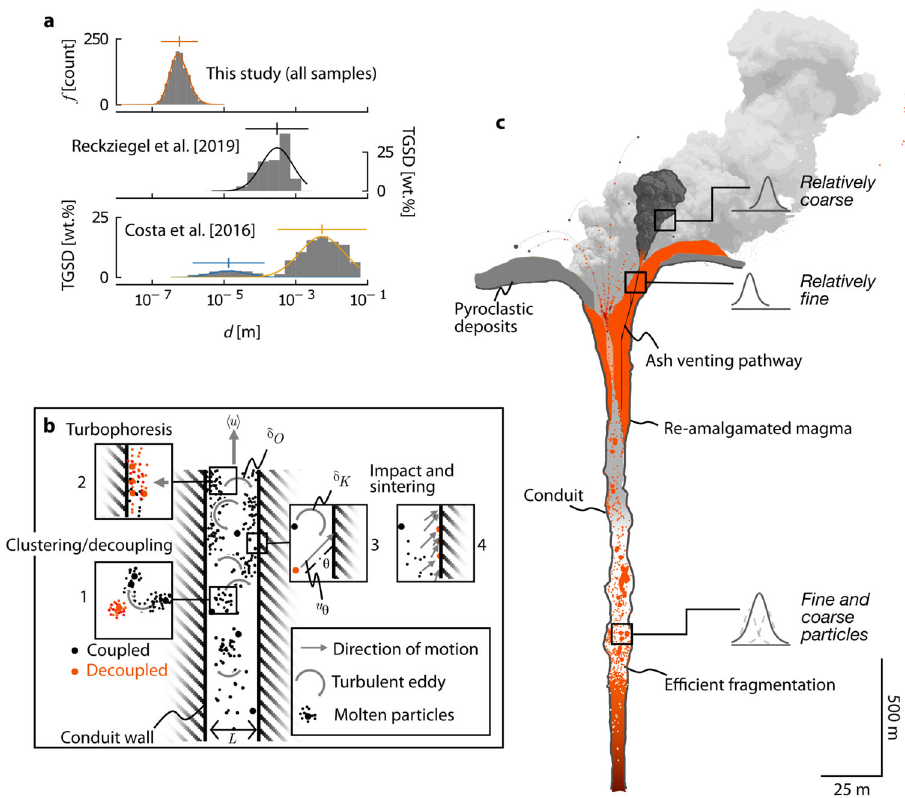
Fig. 5 | A grain size fractionation modelfor CordónCaulle volcano.a Compiled data in this study re fl ecta captured in-conduit fi ne ash fraction, characterised by a mean (as-measured) diameter d of 9.94 ×10 (cid:1) 7 m. For each dataset, best- fi t log- normal curves have been overlain. Distribution assumed by Reckziegel et al. 31 are approximately unimodal and described by mean of d =3.10 ×10 (cid:1) 4 m (based on lognormal assumption of the ash mass fraction). Data of Costa et al. 30